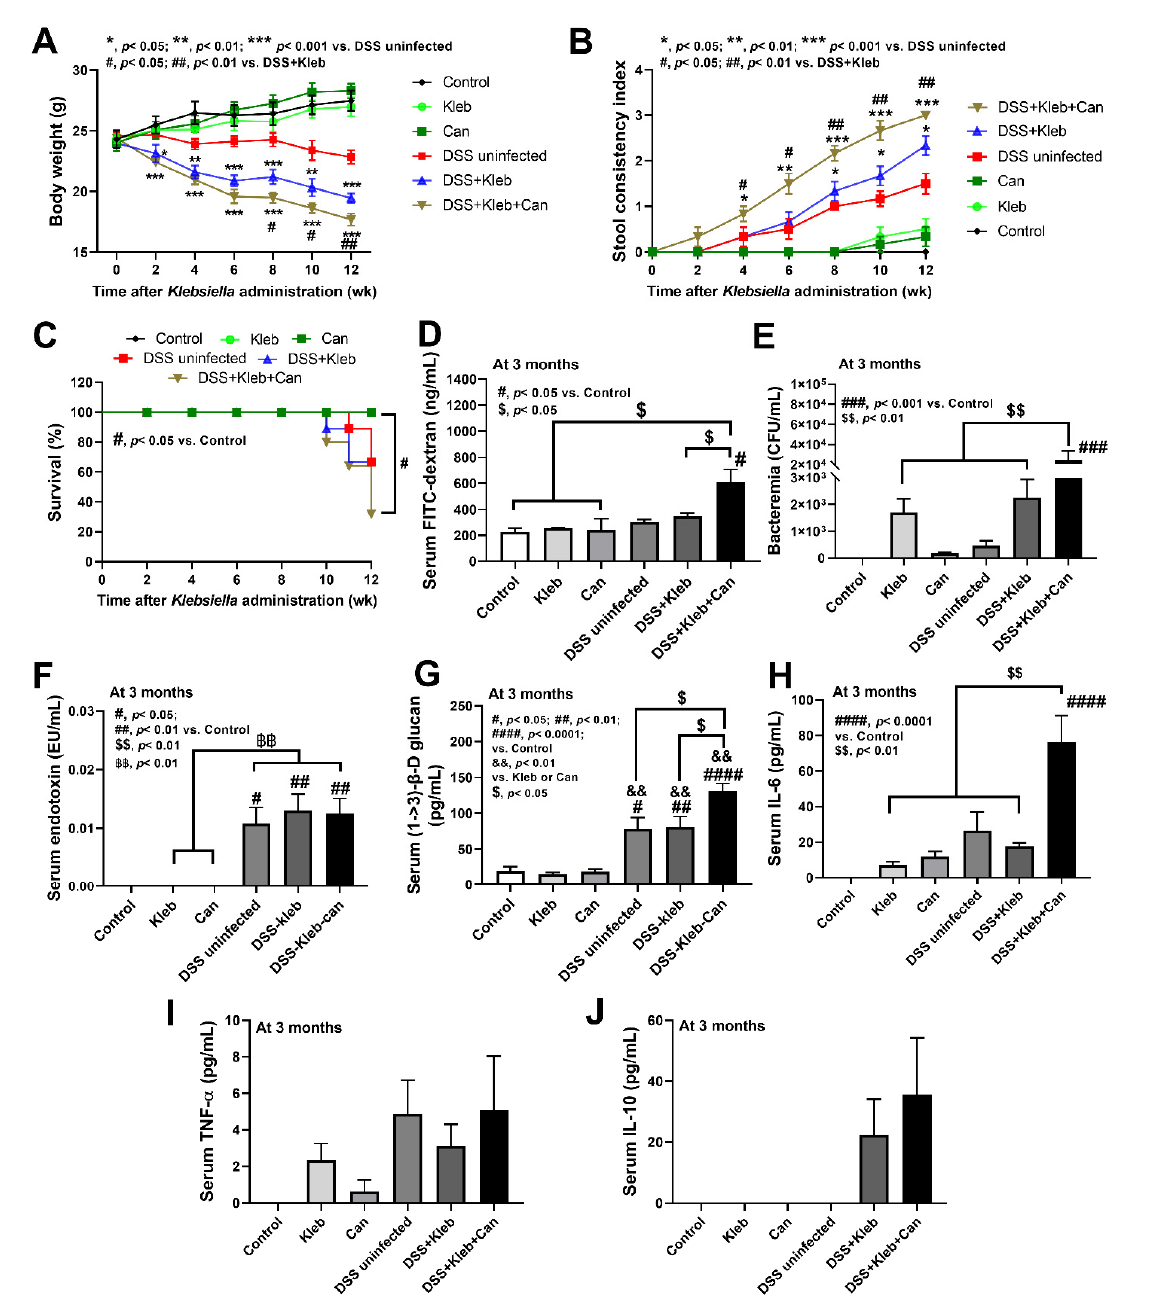
Figure 1. The characteristics of mice after daily gavage with phosphate buffer solution (control), K. pneumoniae (Kleb), or C. albicans (Can) with or without dextran sulfate solution (DSS), as indicated by body weight ( A ), stool consistency index ( B ), survival analysis ( C ), gut barrier defect (FITC dextran assay, bacteremia, endotoxemia, and serum (1 → 3)- β -D-glucan (BG)) ( D – G ), and serum cytokines (IL-6, TNF- α , and IL-10) ( H – J ). (n = 8–10/time-point or group). #, p < 0.05; ##, p < 0.01; ###, p < 0.001; ####, p < 0.0001 vs. control; *, p < 0.05; **, p < 0.01; ***, p < 0.001 vs. DSS uninfected; $, p < 0.05; $$, p < 0.01 vs. DSS-Kleb-Can; &&, p < 0.01 vs. Kleb or Can; ฿฿ , p < 0.01, the indicated groups as determined by ANOVA with Tukey’s analysis.